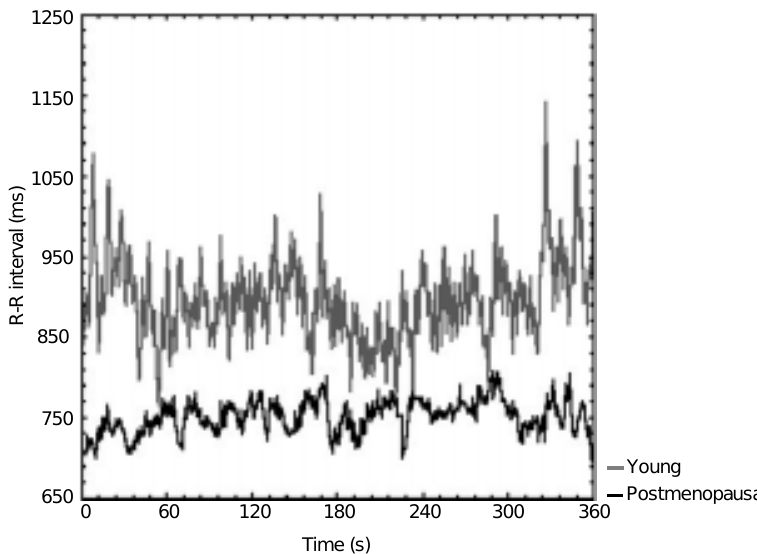
Figure 1. R-R interval, in ms, for the young (gray) and postmenopausal (black) volunteers under resting conditions in the supine position (N = 2).